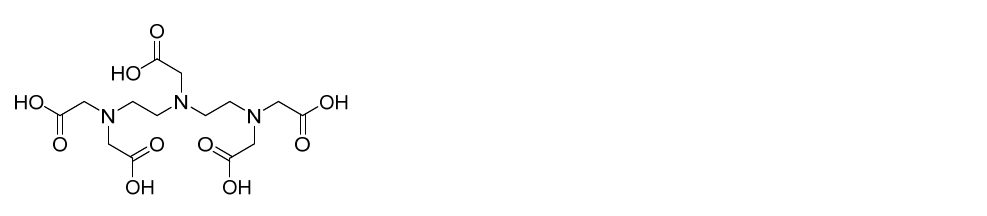
Figure 16. The chemical structure of the broad-spectrum chelator diethylenetriamine pentaacetate (DTPA).